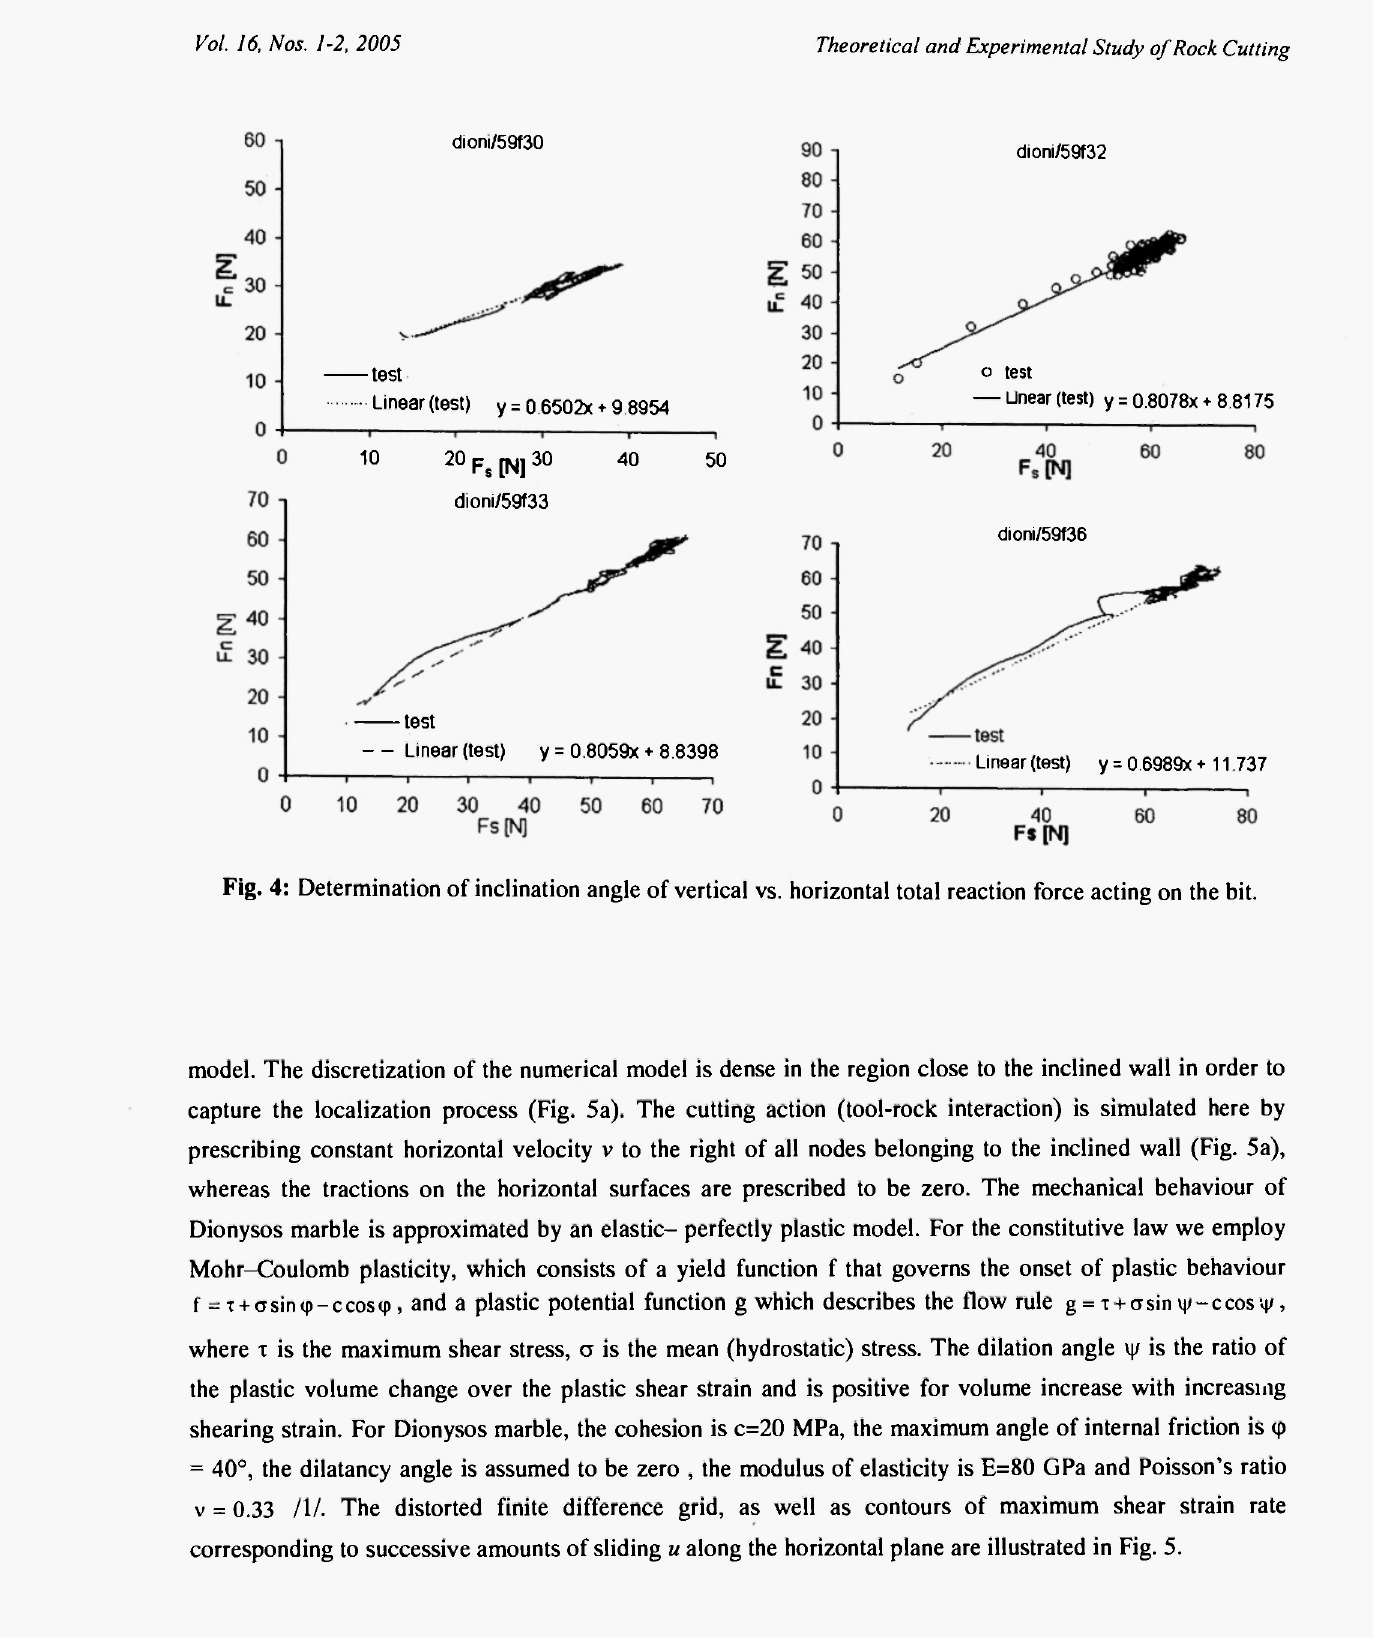
test Linear (test)